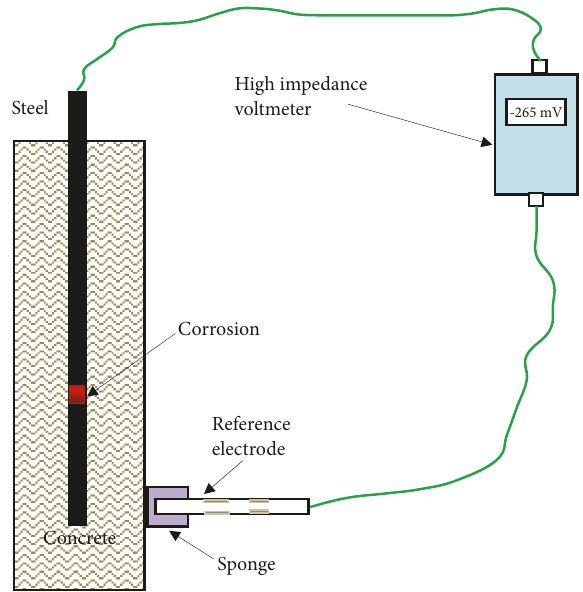
Figure 2: Electrical potential measurement with half-cell potential